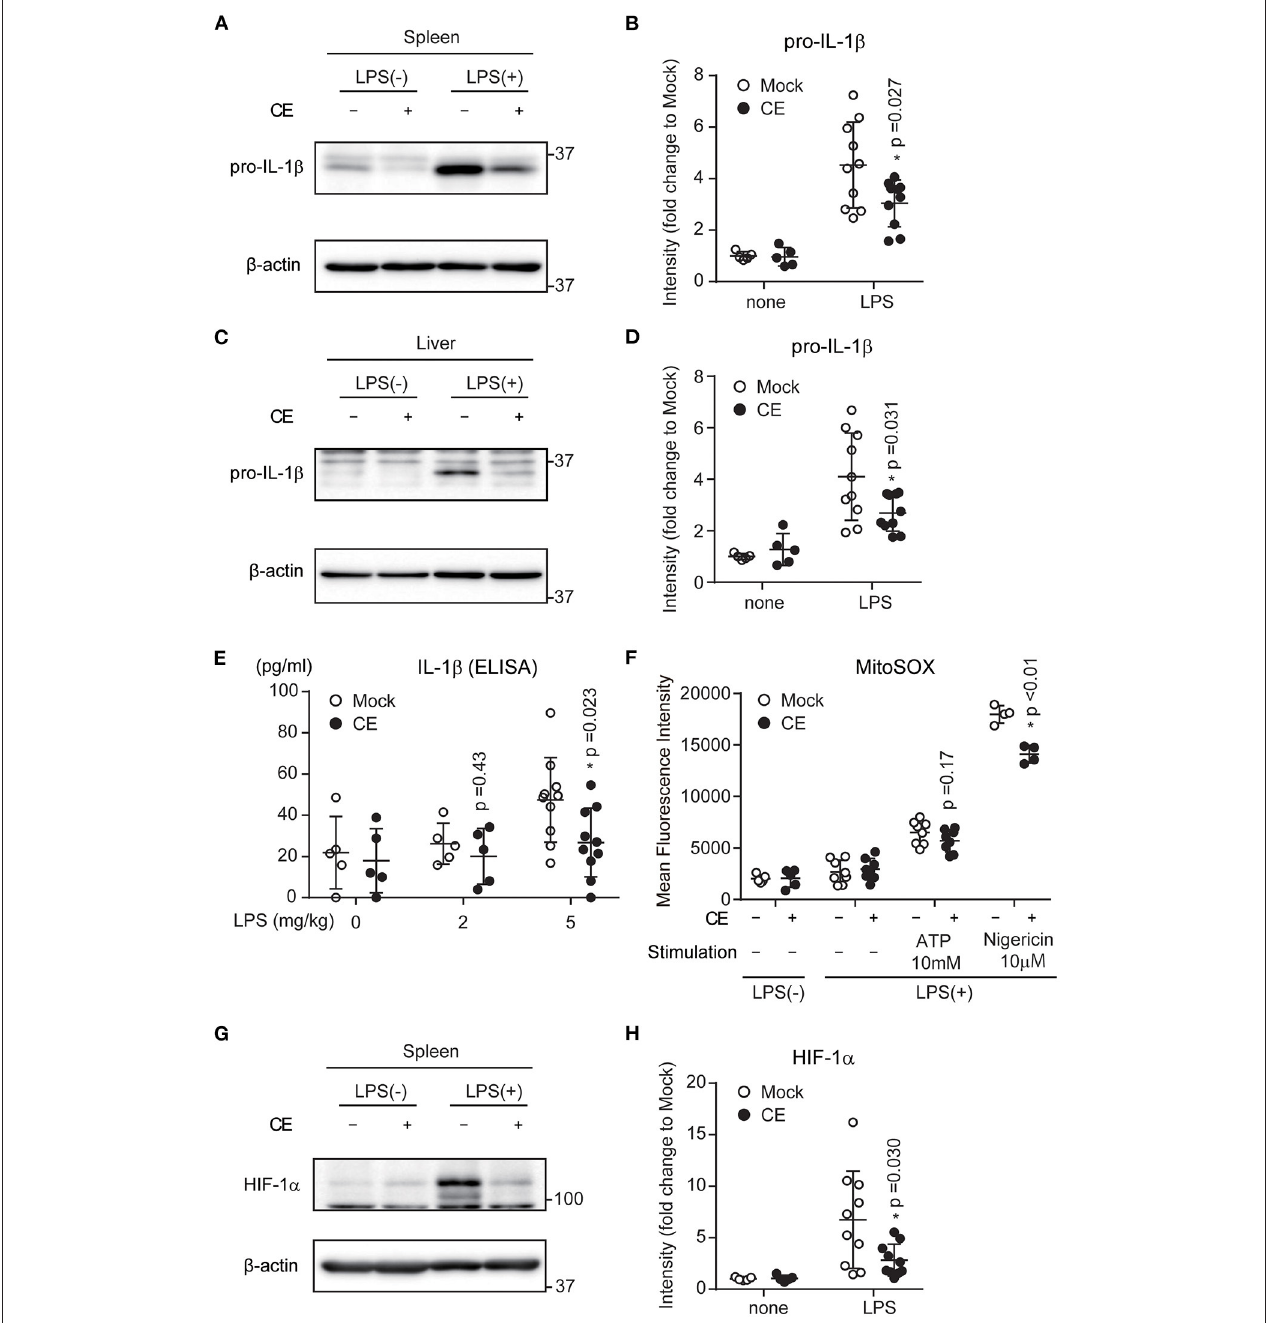
FIGURE 7 | The effect of Chlorella extract on LPS-induced IL-1 β production in vivo . (A–H) Mice were injected intraperitoneally (i.p.) with Mock or CE in PBS for 24h, followed by PBS or LPS (5 mg/kg body weight) for 16h. Spleens and Livers were isolated, and pro-IL-1 β , HIF-1 α were analyzed by western blotting (A,C,G) . A representative western blotting quantification of pro-IL-1 β and HIF-1 α (B,D,H) was normalized to β -actin expression and relative to Mock only treated group. (E) Plasma was isolated from whole blood, and IL-1 β production were analyzed by ELISA. (F) Mice were injected intraperitoneally (i.p.) with Mock or CE in PBS for 24h, followed by PBS or LPS (5 mg/kg body weight) for 4h ( in vivo ), and then collected pMACs. pMACs were stimulated with ATP or nigericin for 30min, and then were stained with MitoSOX Red for 10min and then were analyzed by FACS to measure mitochondrial ROS. Error bar show mean ± SEM. * p < 0.05 vs. Mock-treated groups. Data are representative of at least three independent